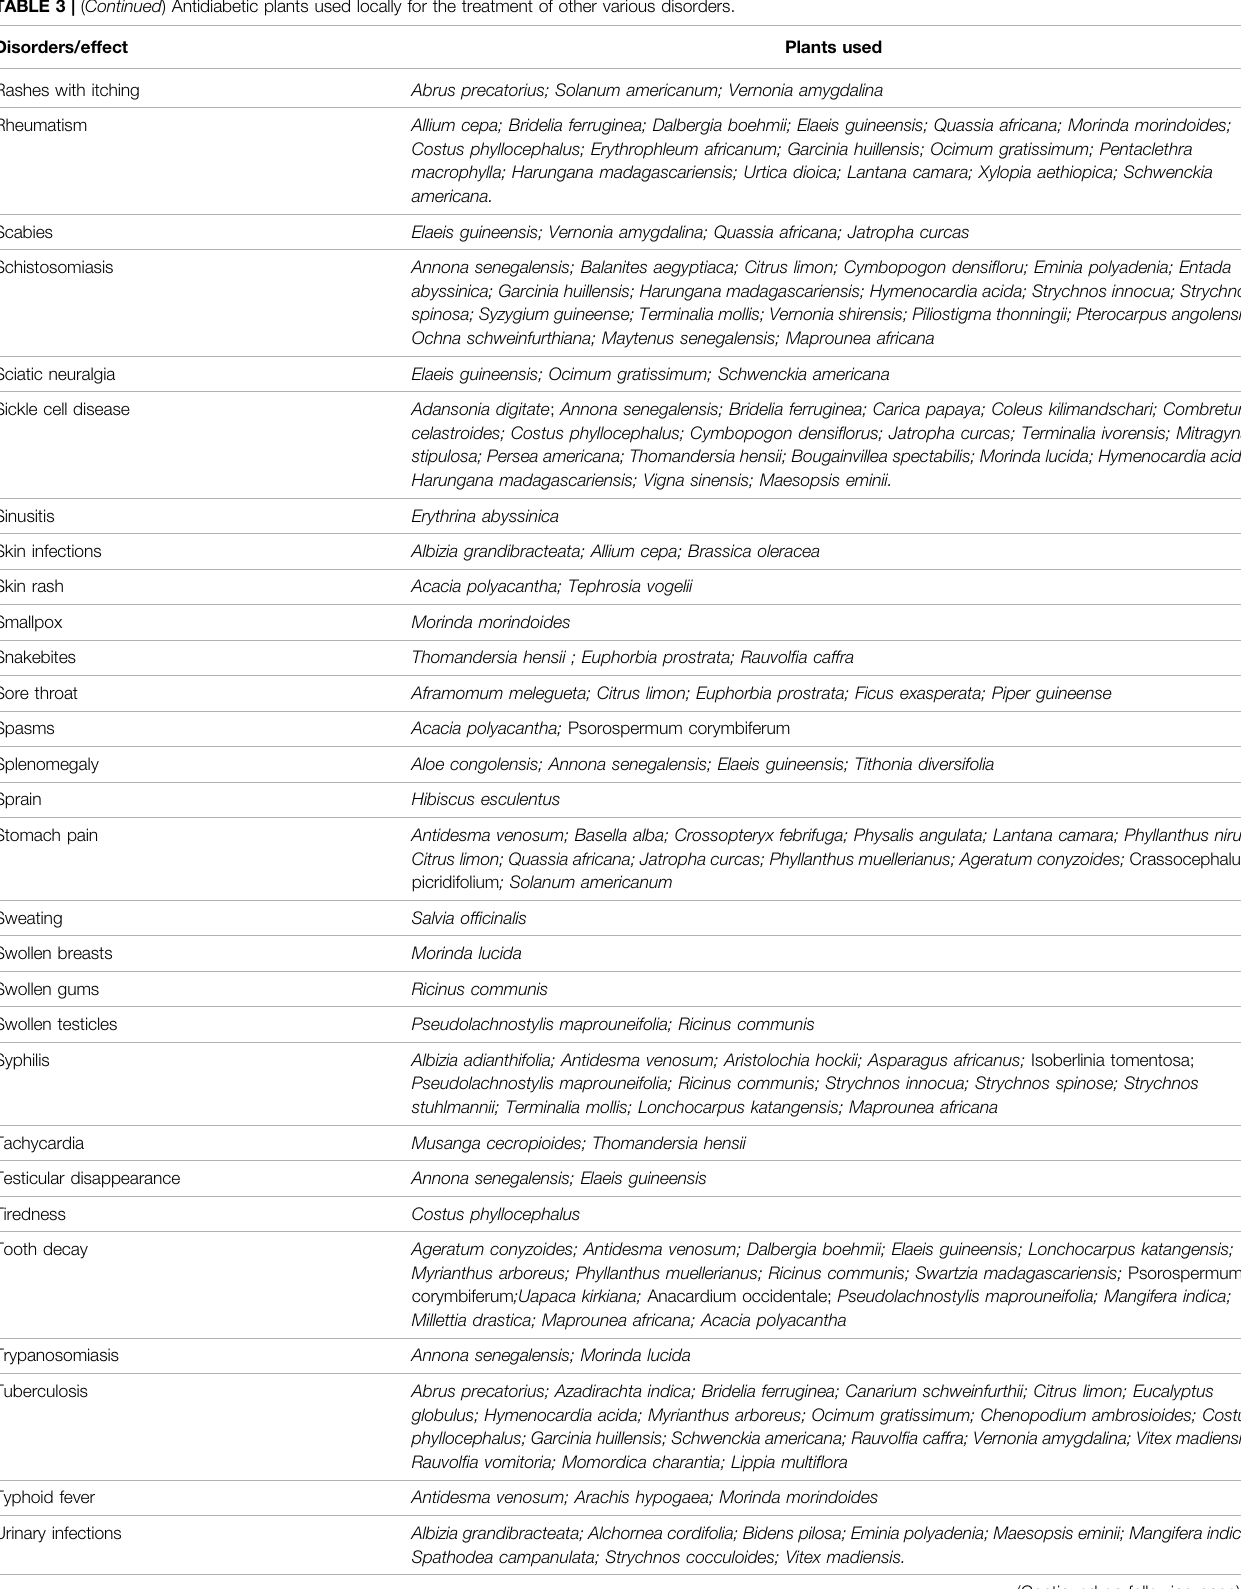
TABLE 3 | ( Continued ) Antidiabetic plants used locally for the treatment of other various